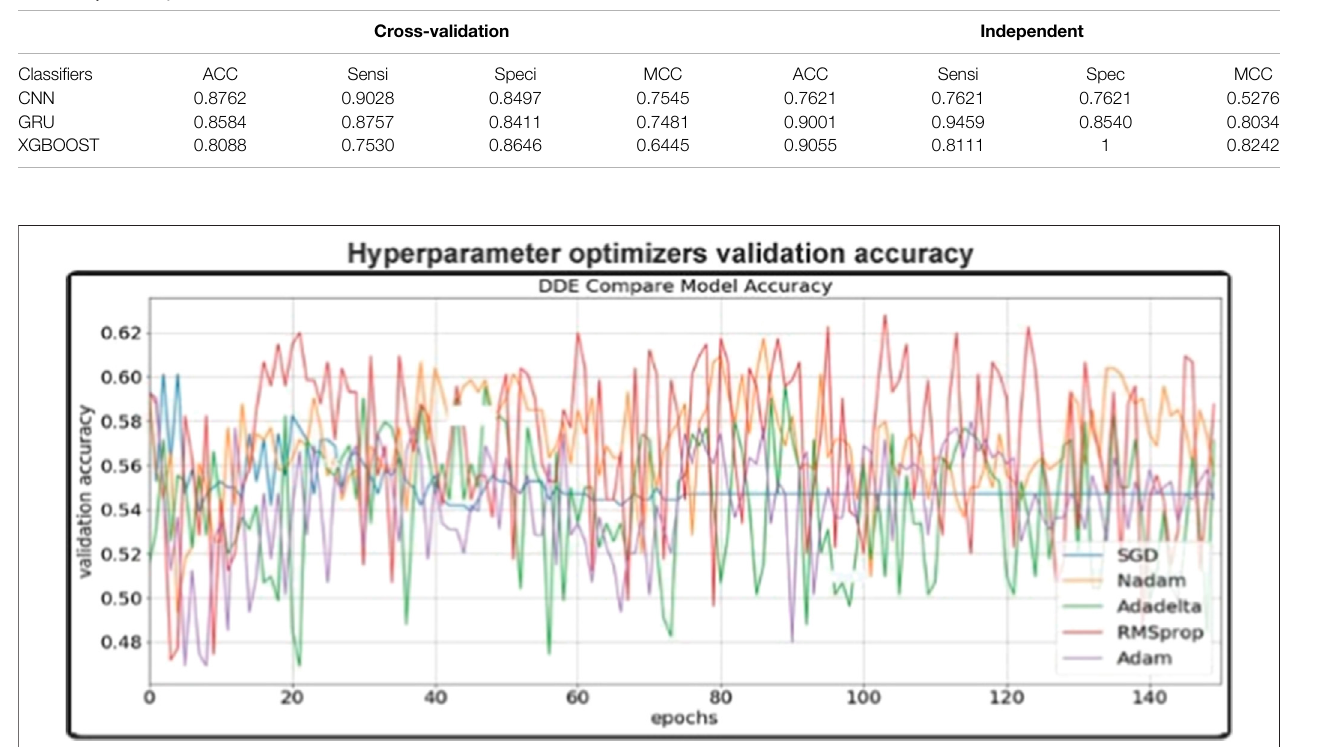
the model output. The test loss value for each cycle is shown in